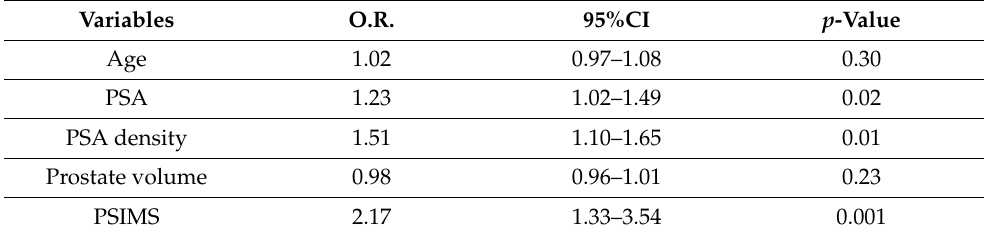
Table 4. Logistic regression for unfavorable